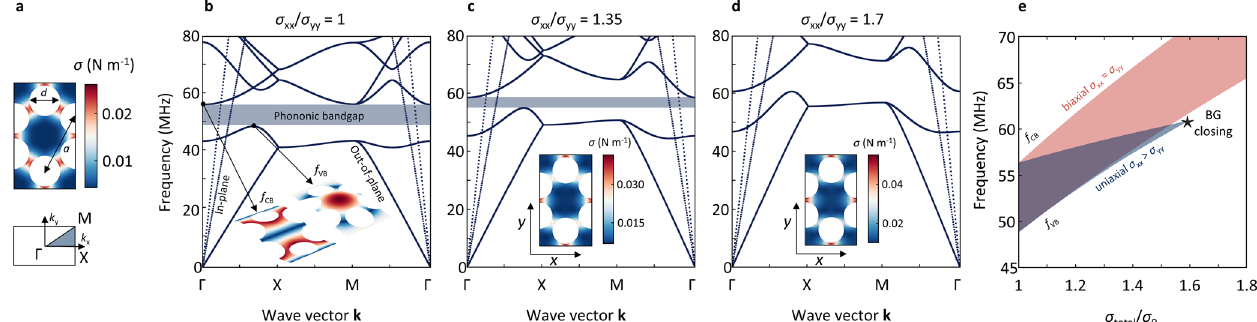
Fig. 1 Phononic bandgap closing induced by uniaxial tension. a Unit cell of the honeycomb lattice with redistributed tension (top) and the corresponding fi rst Brillouin zone (bottom). b Phononic band structure for the unit cell shown in a under uniform tension ( σ xx = σ yy = 0.01 N m − 1 ). For out-of-plane modes (solid lines) a clear phononic bandgap is visible (blue shaded region). The insets show the mode shape (displacement) within the unit cell at the points above and below the bandgap. c , d Phononic band structure and tension distribution in the unit cell (insets) for σ xx / σ yy of 1.35 and 1.7. With increasing uniaxiality in tension ( σ xx / σ yy > 1), the phononic bands show different frequency scaling behaviour along different high symmetry lines. At σ xx / σ yy = 1.7, the phononic bandgap closes. e Phononic bandgap for biaxial (red) and uniaxial (blue) tension vs. total normalised tension. When the tension is increased biaxially ( σ xx = σ yy ), the bandgap centre frequency rises, and the bandgap width increases. On the contrary, uniaxial upscaling ( σ xx > σ yy ) leads to a bandgap